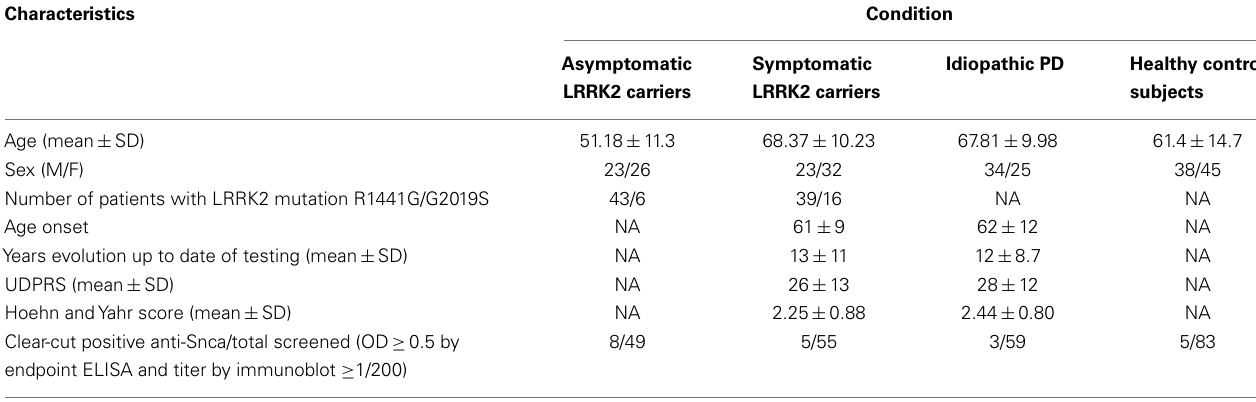
Table 1 | Demographical characteristics of patients and healthy control subjects used for the screening of antibodies against Snca .